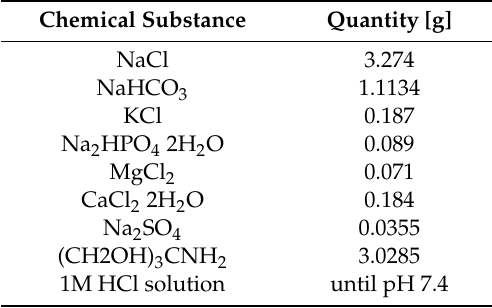
Table 1. Simulated body fluid (SBF) receipt